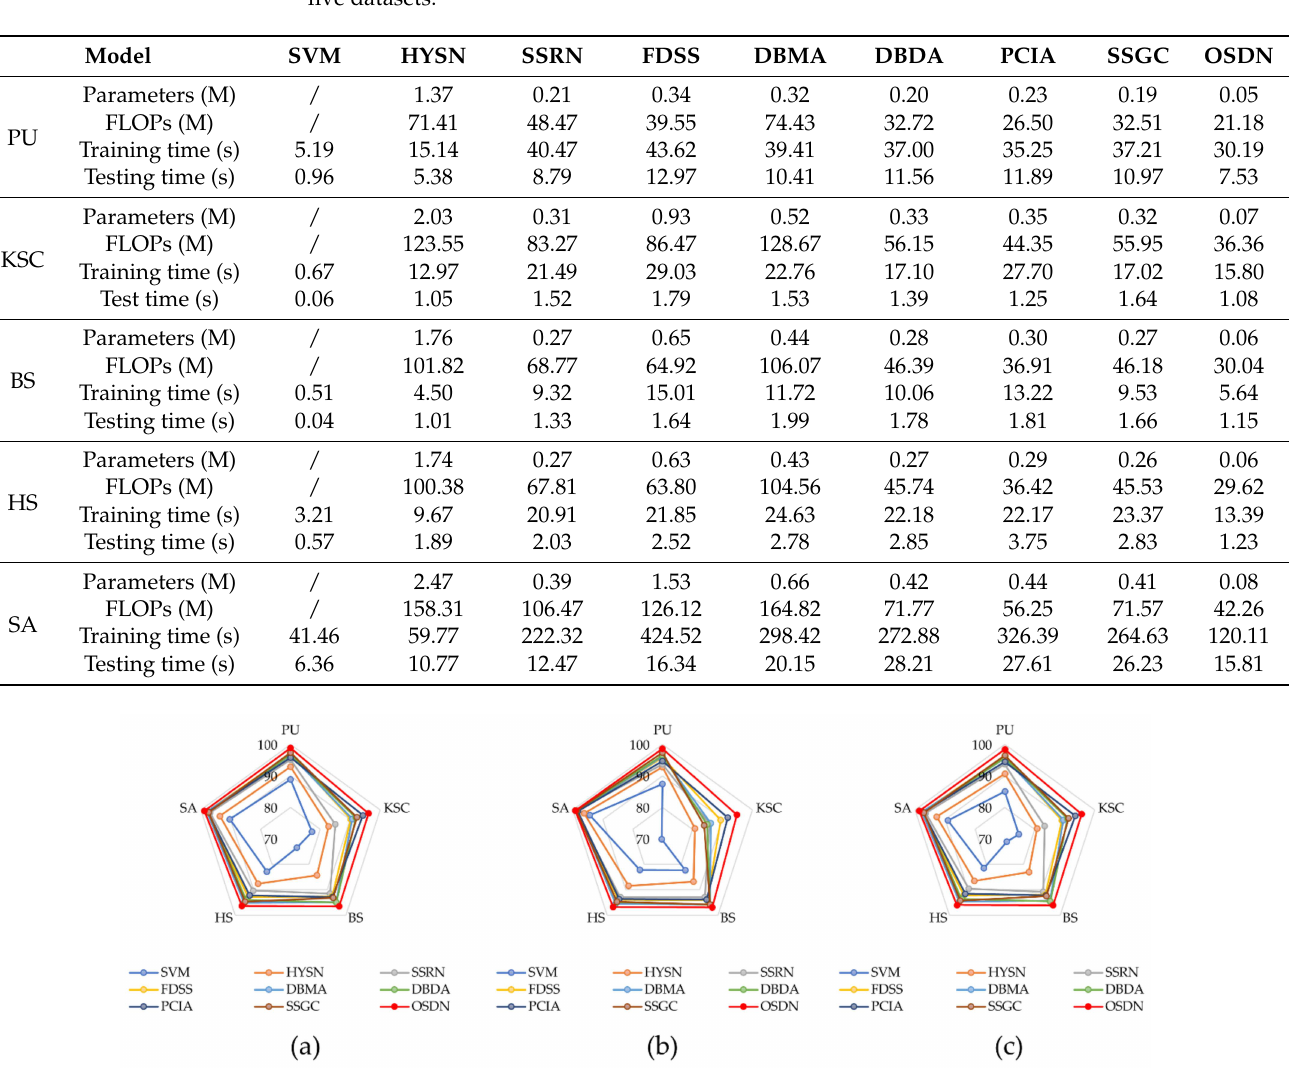
Figure 14. Classification results at different methods on the five datasets. ( a ) OA . ( b ) AA . ( c ) Kappa